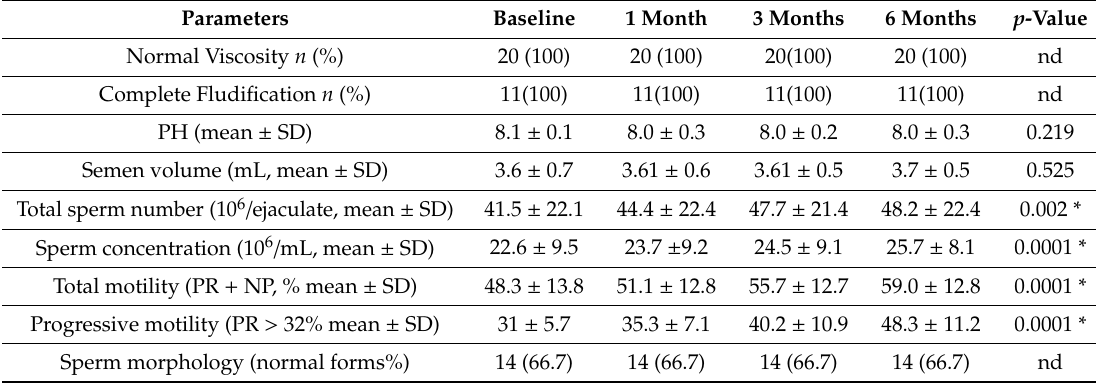
Table 2. Semen parameters at baseline 1, 3, and 6 months after recruitment.